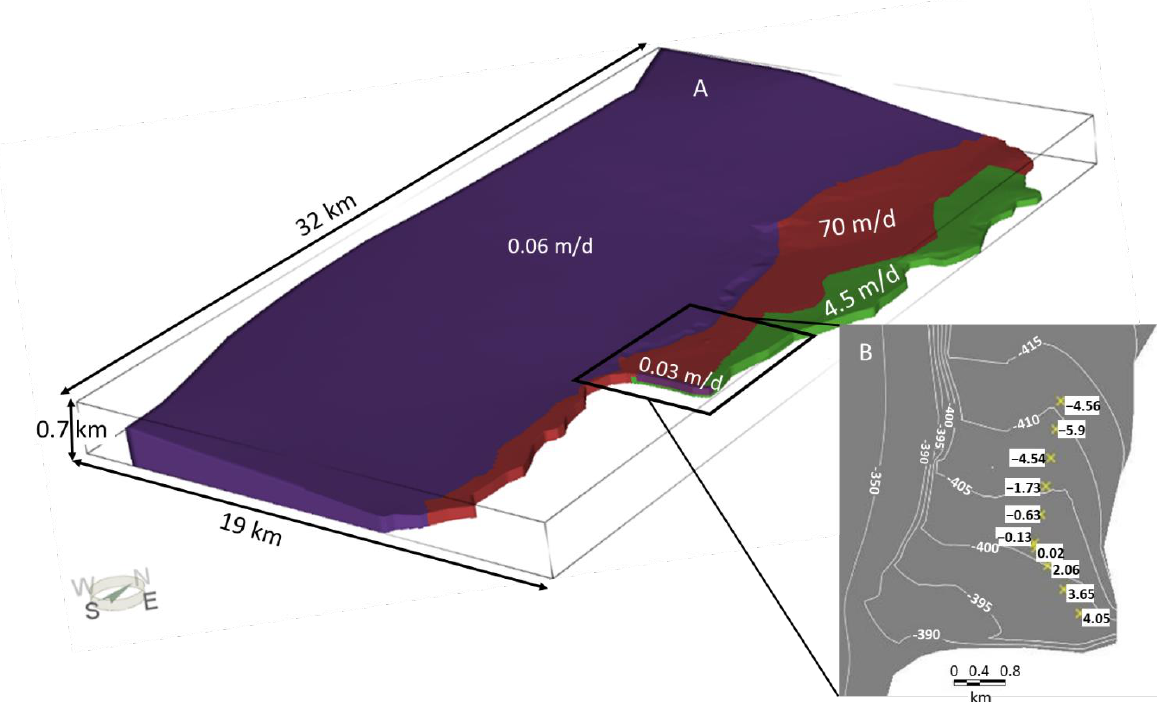
Figure 7. ( A ) Calibrated hydraulic conductivities of the lithological units. ( B ) Best-fitted groundwater head distribution for the 2017–2020 period, and the differences between measured and observed heads at each of the new boreholes.